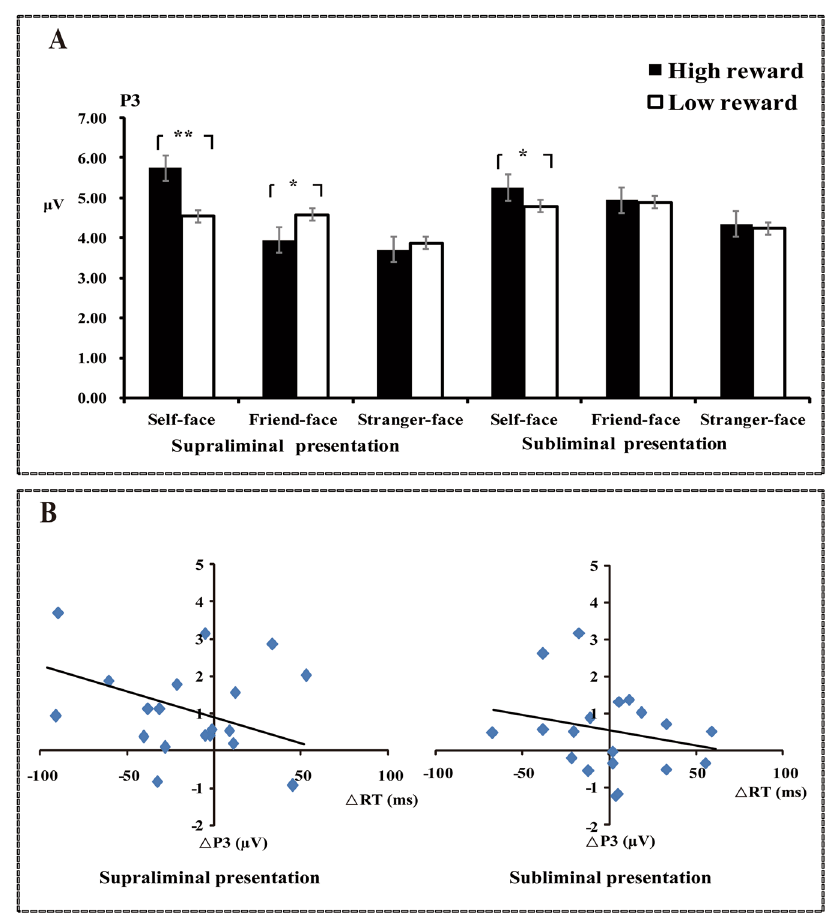
Figure 3. The topographical maps of voltage amplitudes for high reward minus to low reward in supraliminal and subliminal presentation condition difference ERPs at P3(350–450 ms) of self-face, friend-face, and